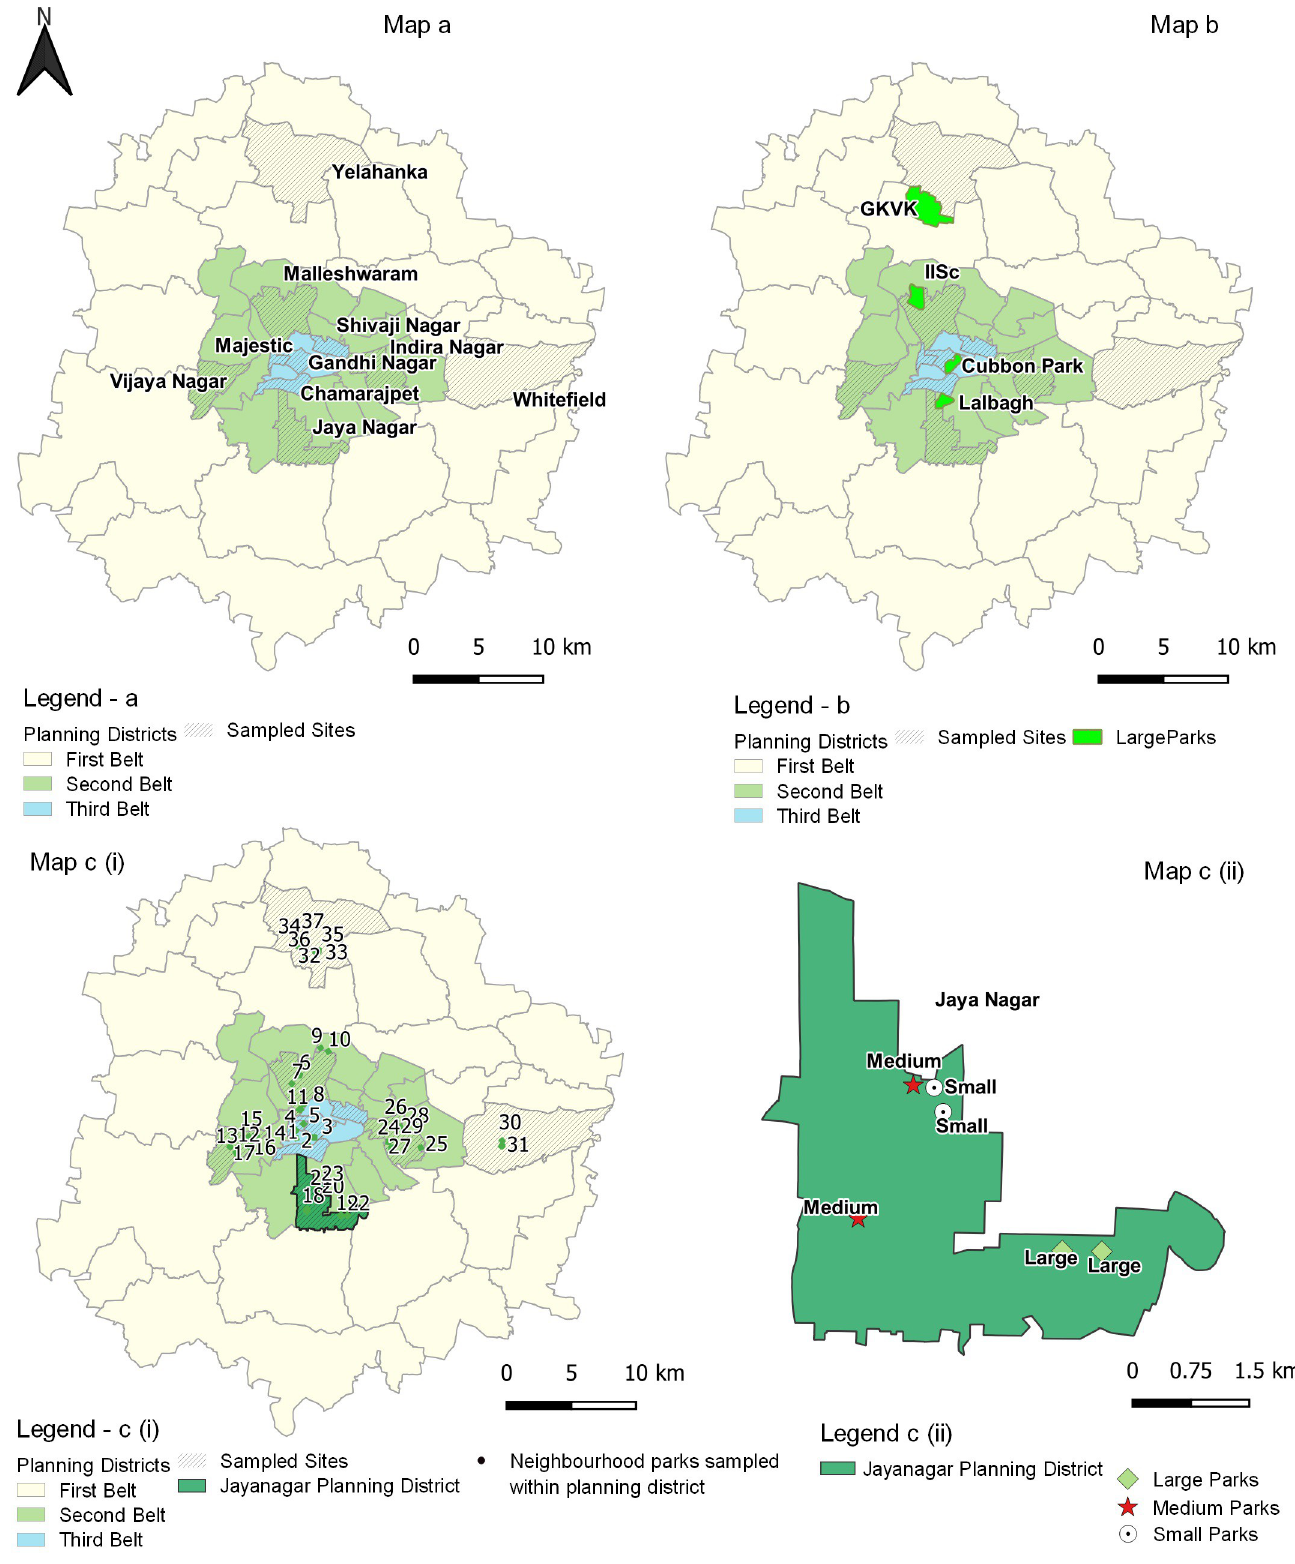
Fig 1. Map of Bangalore (A) With 10 districts sampled across the three zones; (B) Location of the four large green spaces sampled across Bangalore; (C) Map a: Distribution of the 37 Neighbourhood Parks sampled across the city; Map b: close up of Jayanagar District and the NPs distribution within the district.planning.